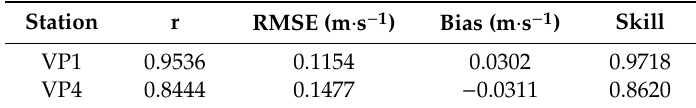
Table 6. Error metrics for the current velocities measured in the entire water